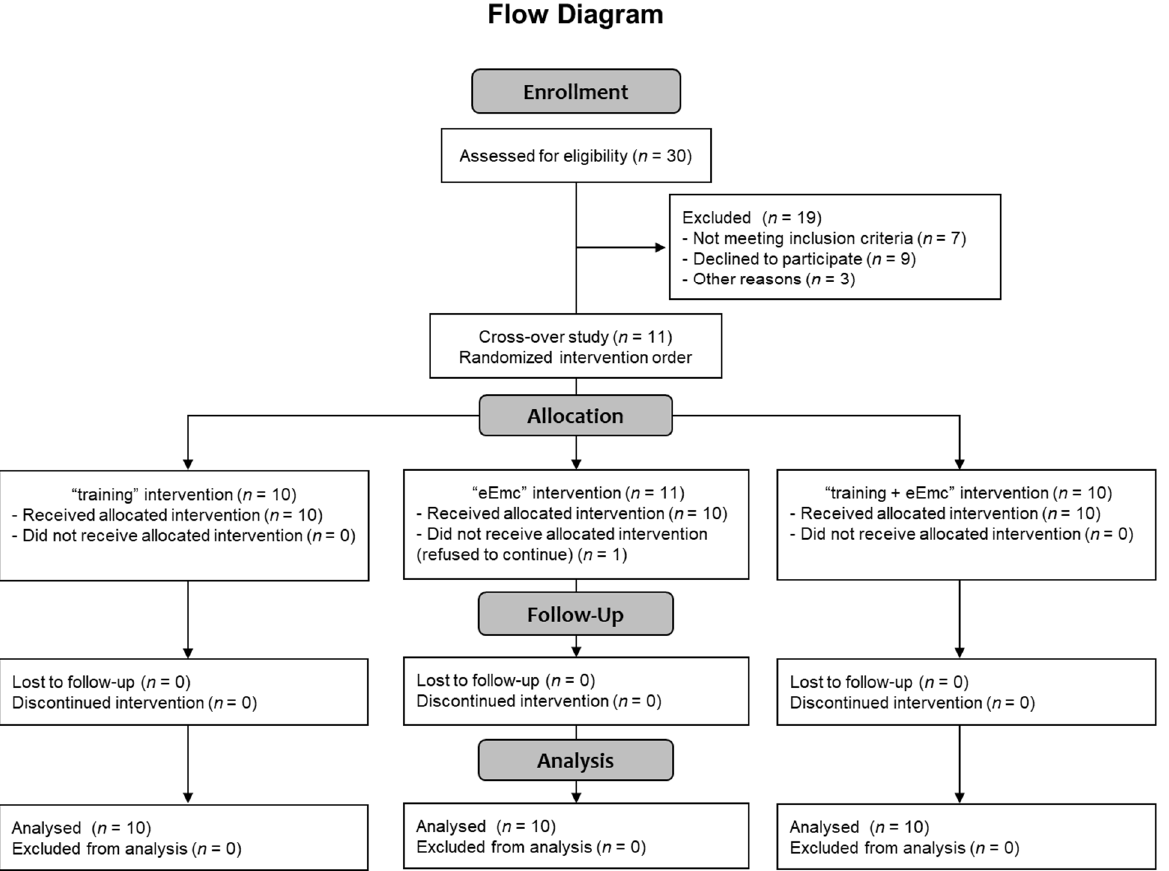
Figure 1. CONSORT 2010 flow diagram showing the number of subjects involved in each phase of the study.